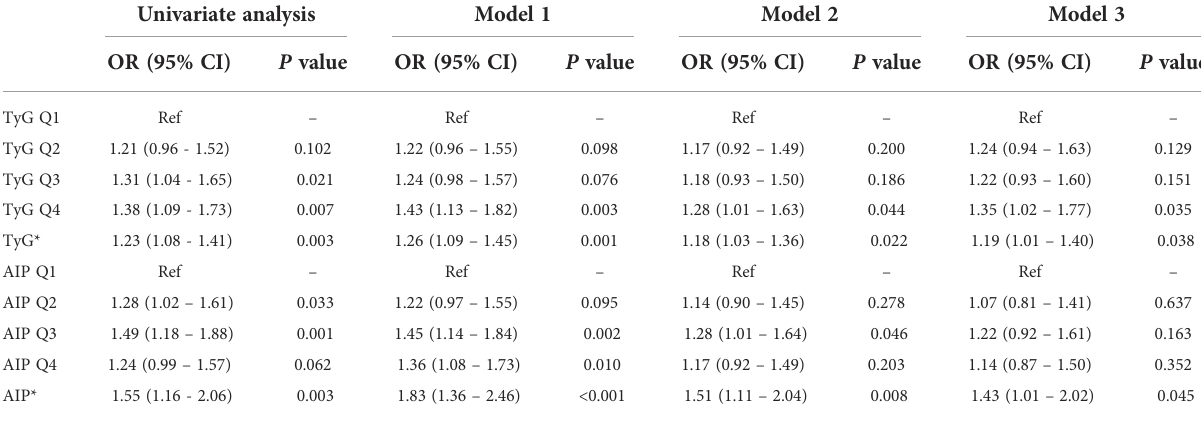
TABLE 2 Logistic regression analyses of associations between TyG, AIP index and neoplasm.